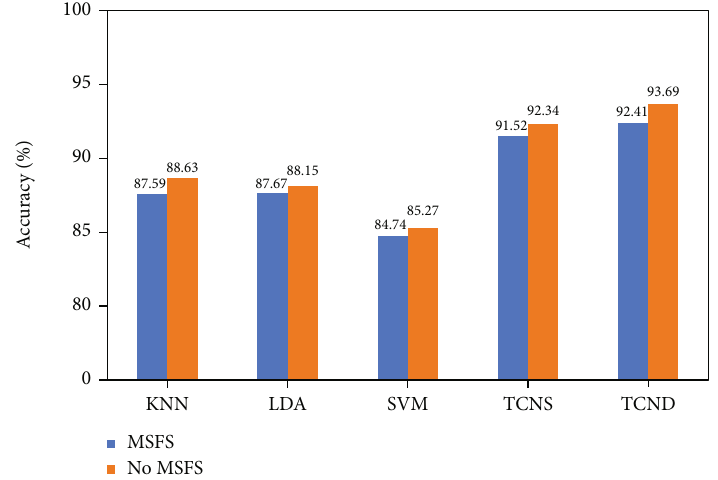
Figure 12: Accuracy curve of network training set.